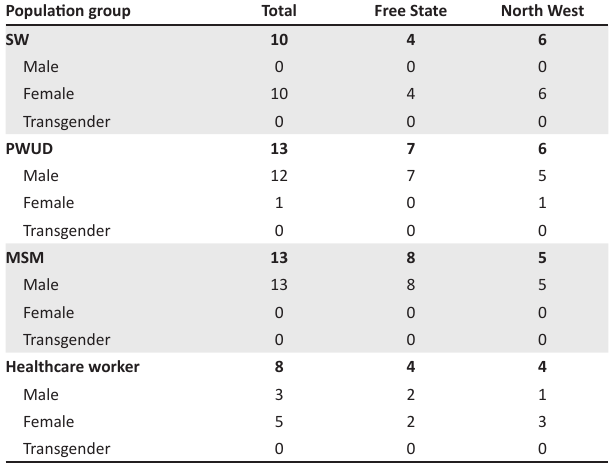
TABLE 1: Baseline respondent